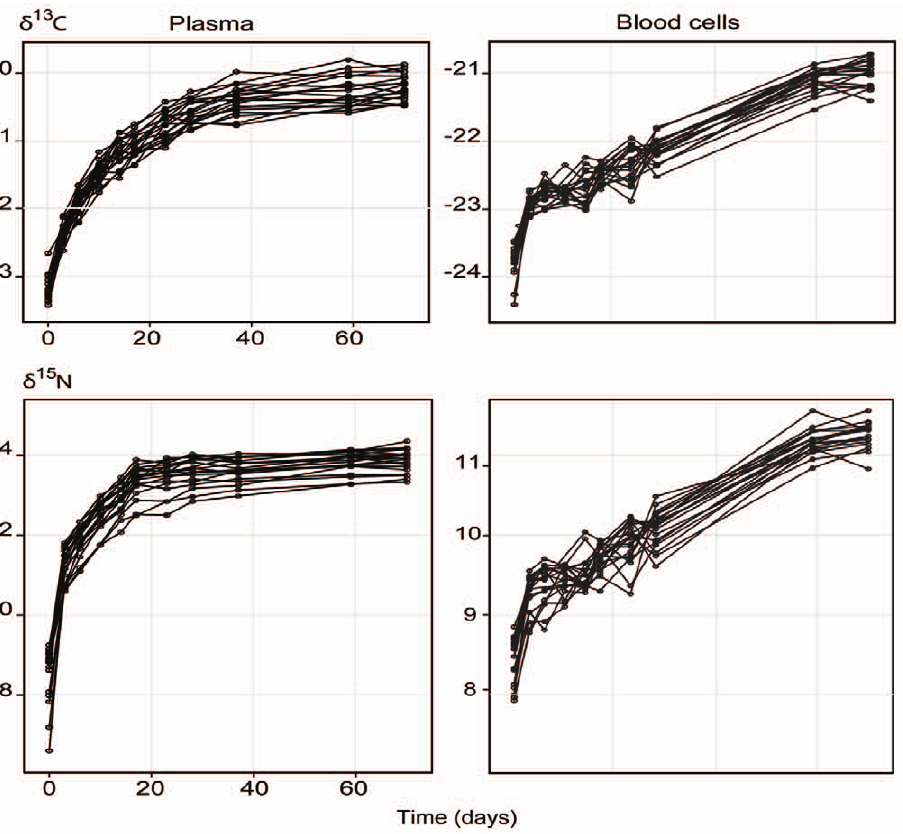
Figure 3. Stable-carbon/nitrogen isotopes’ turnover for plasma and blood cells of arctic foxes. Turnover are illustrated with one line trajectories per individual (n=20 corresponding to animals shifted from a terrestrial diet to a marine one). Model estimates of isotopic half-lives are provided in Table S4.